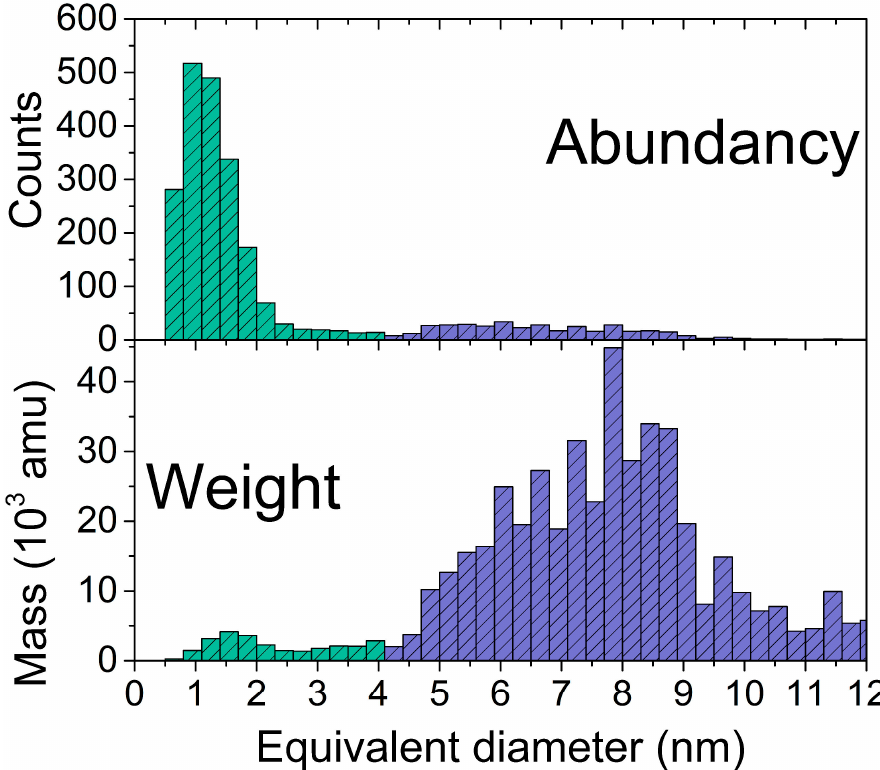
Figure A2. Size and mass distribution statistics of Ag NPs vs apparent diameters from TEM images. Particles with diameters less than 4 nm are identified in the green bins, while larger particles are collected in blue colored bins. Smaller than 4 nm NPs collect the 95% count of total particle number while their volume or mass is only 5% of total.